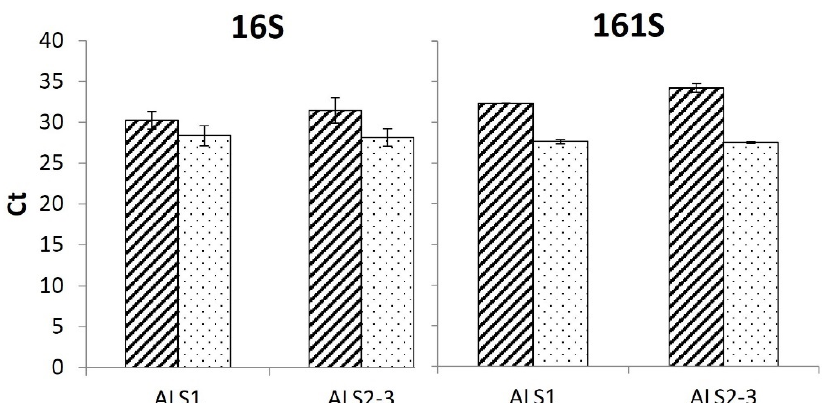
Figure 6. Ct of ALS1 and ALS2-3 amplified on the susceptible populations, 16S and 161S. Hatched bars indicate the mean values of the untreated plants, whereas dotted bars indicate the mean values of the treated plants. Thin bars represent the standard errors.